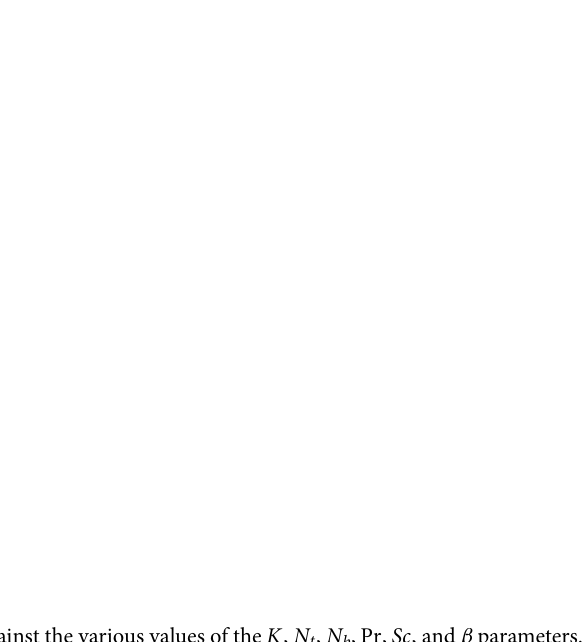
Table 3. Numerical results for Sh x Re − 0.5 against the various values of the K , N t , N b , Pr , Sc , and β parameters.